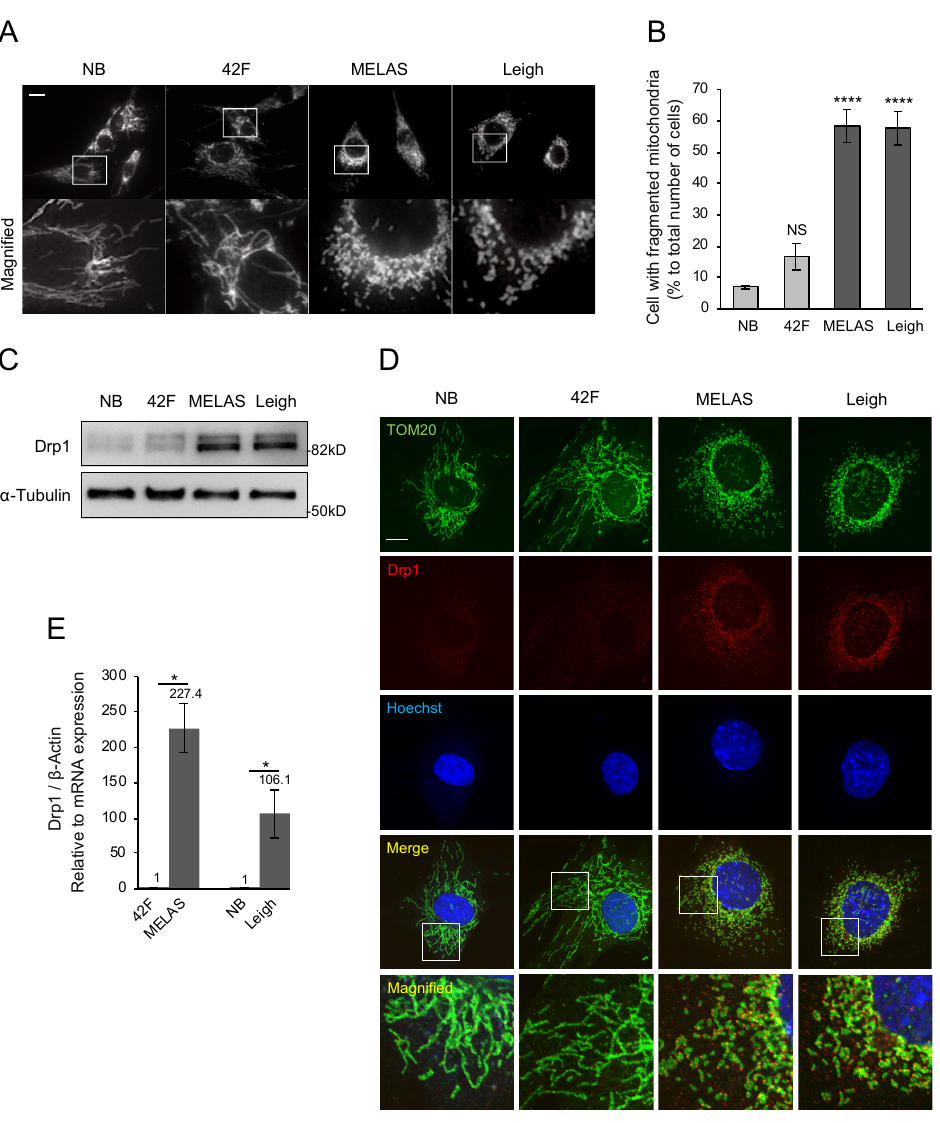
Figure 4. Mitochondrial fragmentation in MD fibroblasts. ( A , B ) Mitochondrial fragmentation is increased in MD fibroblasts. Cells were stained with anti-Tom20 antibody. Scale bar represents 20 µ m. Fragmented mitochondria are defined in Supplementary Figure S1A. Quantification was performed from 300 cells per experiment examined in three separate experiments. Data are shown as the mean ± SEM. Statistical analysis was performed with one-way ANOVA followed by Dunnett’s test. **** P < 0.0001 compared with NB. ( C ) Mitochondrial morphology-related proteins were analyzed by Western blotting. MD fibroblasts had increased Drp1, and alpha-tubulin was used as loading control. ( D ) Anti-Tom20 and anti-Drp1 antibodies were used to visualize mitochondria and Drp1. Drp1 accumulates on mitochondria in MD fibroblasts. Scale bar represents 10 µ m. ( E ) Drp1 expression levels were analyzed by qRT-PCR and compared to age-related controls ( n = 3 independent experiments). * P < 0.05 (Student’s t